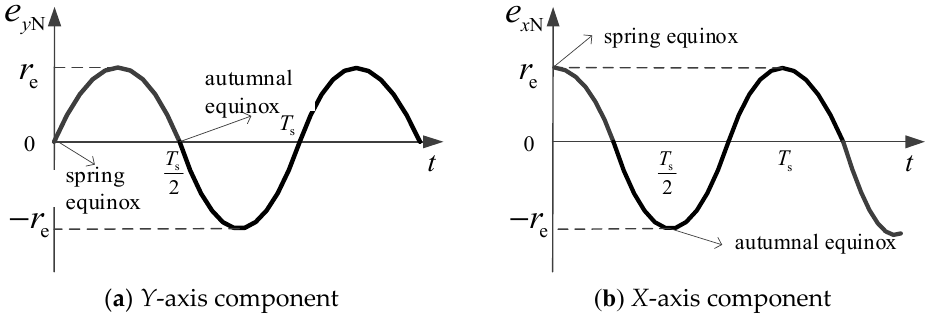
Figure 2. Uncontrolled eccentricity vector.